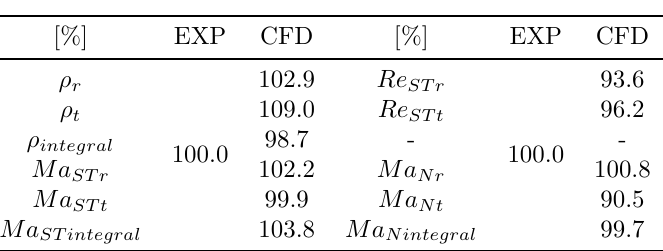
Table 3. Comparison of last stage flow parameters.